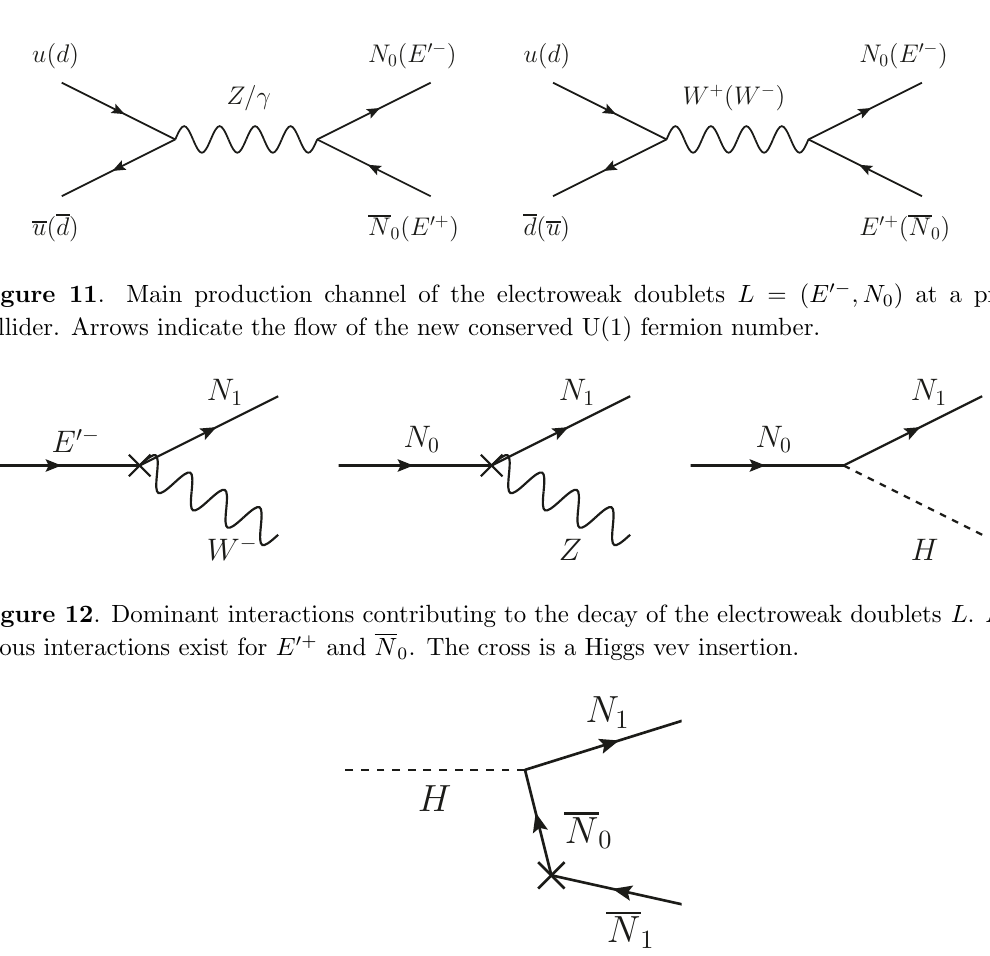
Figure 13 . Higgs boson decay into a pair of light, invisible fermions. The cross is a Higgs vev